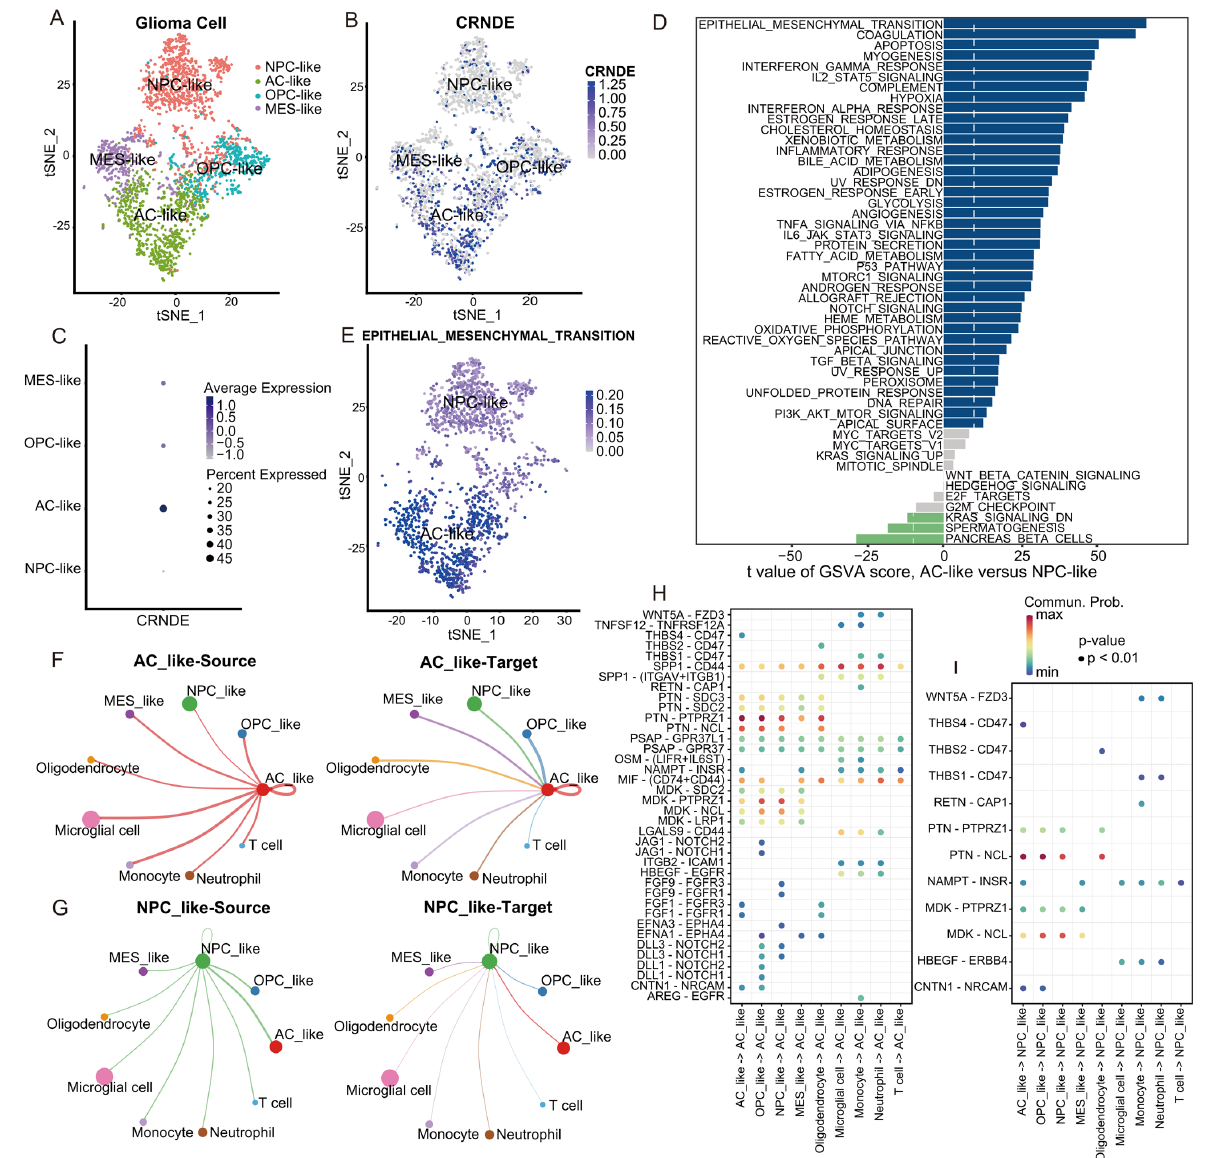
Figure 8. Biological processes and cell–cell communications associated with the expression of CRNDE at the single-cell level. ( A , B ) tSNE plot of the glioma cells with each cell color-coded by ( A ) minor subtype and ( B ) the expression level of CRNDE. ( C ) CRNDE expression in four minor subtypes of glioma cells quantified by bubble plot. ( D ) Differences in pathway activities scored per cell by GSVA between AC-like and NPC-like glioma cells. ( E ) tSNE plot of AC-like and NPC-like glioma cells with each cell color-coded by GSVA score of the EMT process. ( F , G ) The number of ligand–receptor interactions associated with ( F ) AC-like glioma cells and ( G ) NPC-like glioma cells. ( H , I ) EMT-related ligand–receptor interactions associated with ( H ) AC-like glioma cells and ( I ) NPC-like glioma cells.